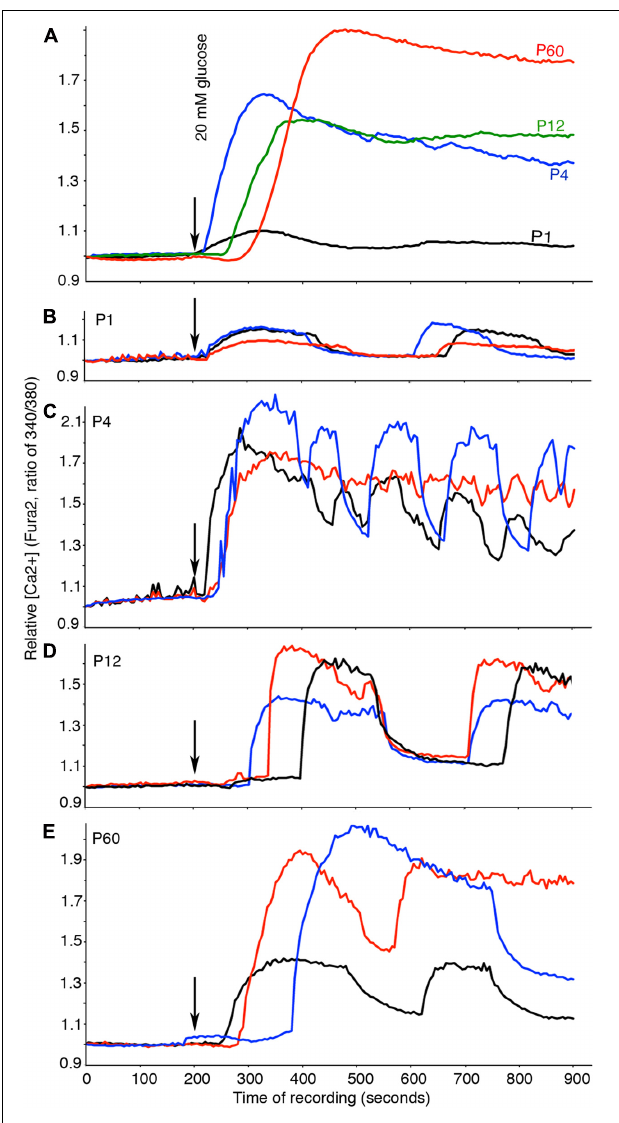
FIGURE 7 | Glucose-induced Ca 2 + influx is established in immature β cells. Free Ca 2 + was recorded by Fura2 fluorescence. Basal glucose was used for the first 200 s, and then 20 mM glucose was used to stimulate islets. (A) Average Ca 2 + responses of islets at each stage ( n ≥ 69). (B–E) Examples of oscillating Ca 2 + in three different islets. The color of lines here indicate different islets of same stages. The numbers of mice used were as